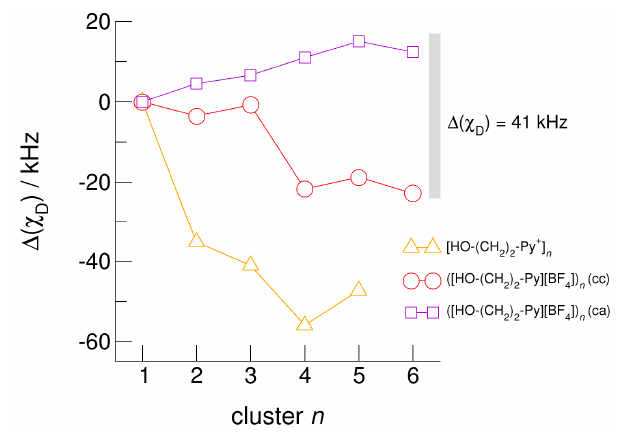
Figure 15. Average deuteron quadrupole coupling constants, χ D , of the hydroxyl deuterons for the cationic clusters [HO-(CH 2 ) 2 -Py + ] n (triangles), the neutral clusters ([HO-(CH 2 ) 2 -Py][BF 4 ]) n (c–c) (circles) and ([HO-(CH 2 ) 2 -Py][BF 4 ]) n (c–a) (squares) related to the corresponding monomer values calculated at the B3LYP-D3/6–31+G* level of theory. The grey bar indicates the Δ ( χ D ) = 41 kHz difference between the (c–c) and (c–a) hydrogen bonds in the ionic liquid [HO-(CH 2 ) 2 -Py][NTf 2 ] as observed in NMR solid state experiments at the glass transition [25].